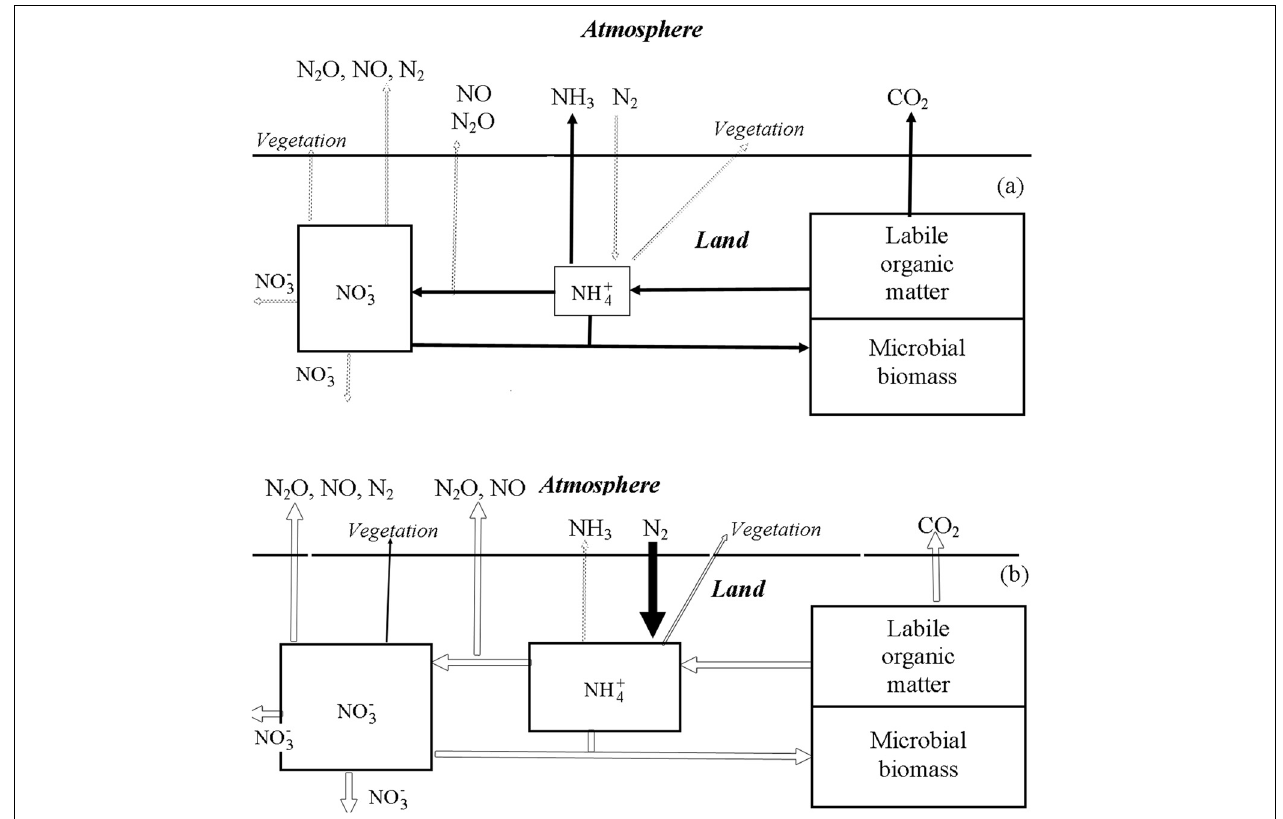
FIGURE 6 | Block-diagram of biogeochemical cycles of C and N in the water-limited ecosystems (Krapivin and Varotsos, 2008). (A) Dry season; (B) wet